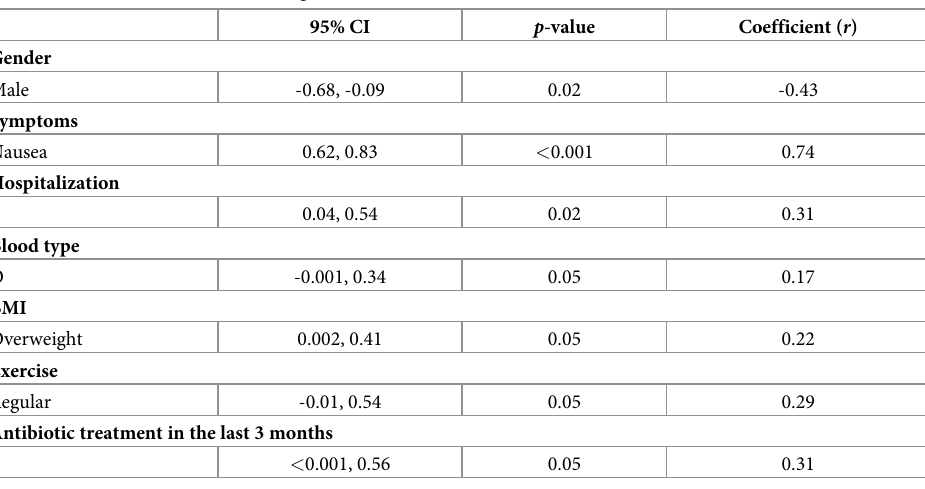
( r (51) = 0.74, p < 0.001), hospitalization during COVID-19 infection ( r (51) = 0.30, p = 0.0), and blood type O ( r (51) = 0.17, p = 0.05). In cases that tested positive in stools and either posi- tive or negative in nasopharyngeal swabs, higher viral load in stools correlated with being over- weight ( r (82) = 0.22, p = 0.05), exercising ( r (82) = 0.29, p = 0.05), and taking antibiotic Table 2. Factors associated with changes in viral load in